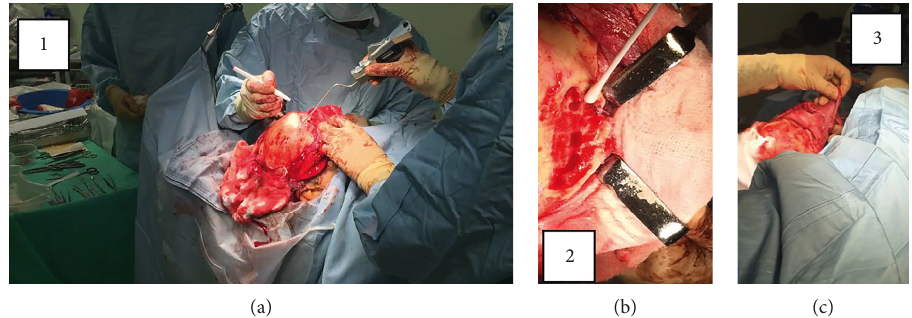
Figure 3: Operative methodology. (a) Bicoronal approach under image guidance used to mark out frontal sinus and lateral limits. (b) Washout and debridement of infective mucosa and bone (subsequent extensive chamfering). (c) Raising of thick pericranium tissue which included periosteum, galea muscle, and some temporalis.